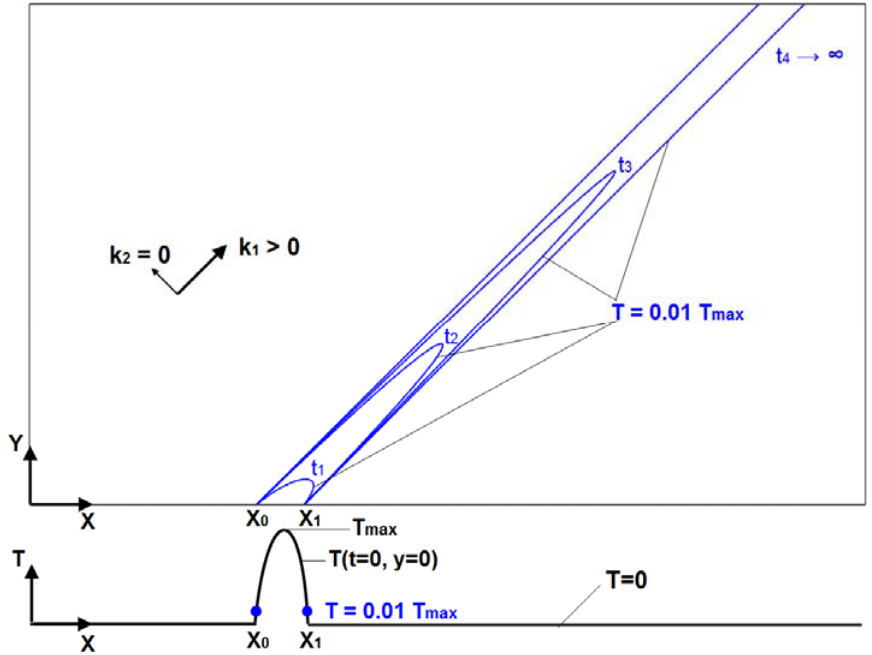
Figure 4. The steady-state problem from Figure 3 analyzed in the time domain. The isotherms are parallel to the given direction field y´ = 1 only for the final steady state when t → ∞